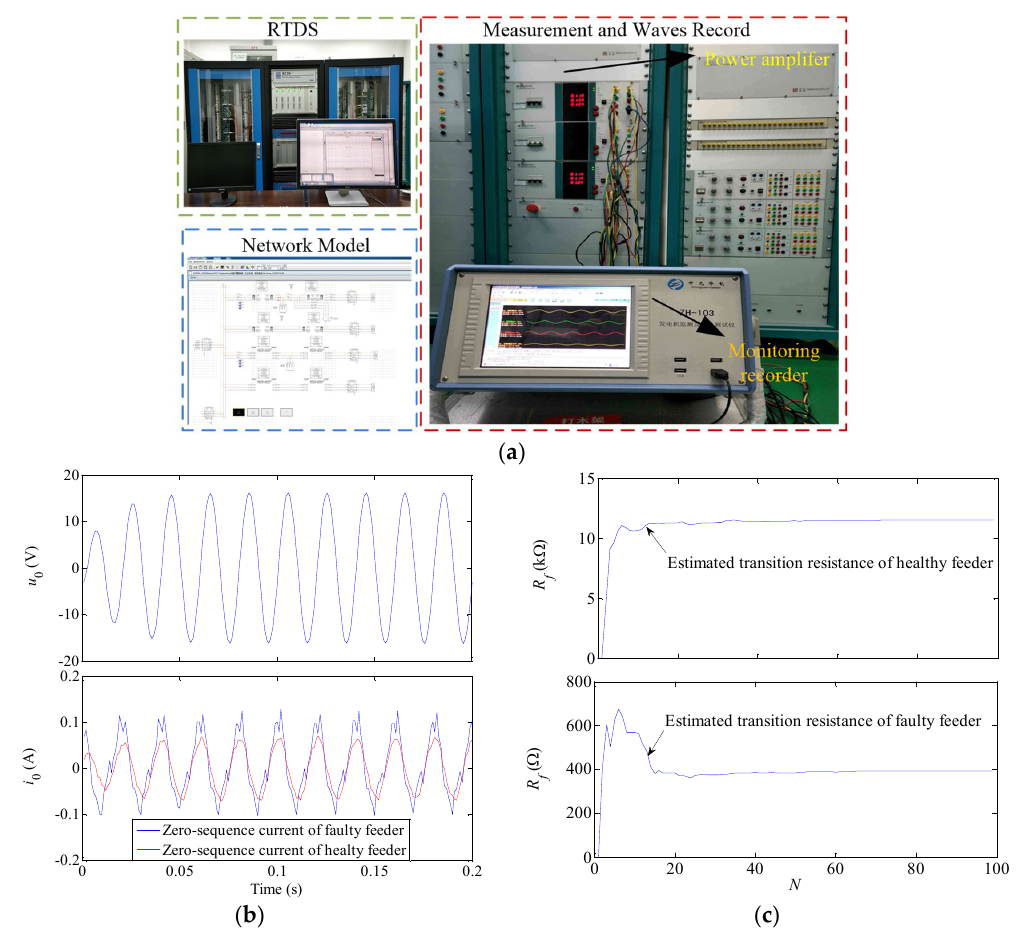
Figure 9. Experiment platform based on RTDS and simulation results of the proposed method. ( a ) Experiment platform based on RTDS; ( b ) Bus zero-sequence voltage and zero-sequence currents of a faulty feeder and a healthy feeder; and ( c ) Estimated transition resistances for the faulty feeder and a healthy feeder.